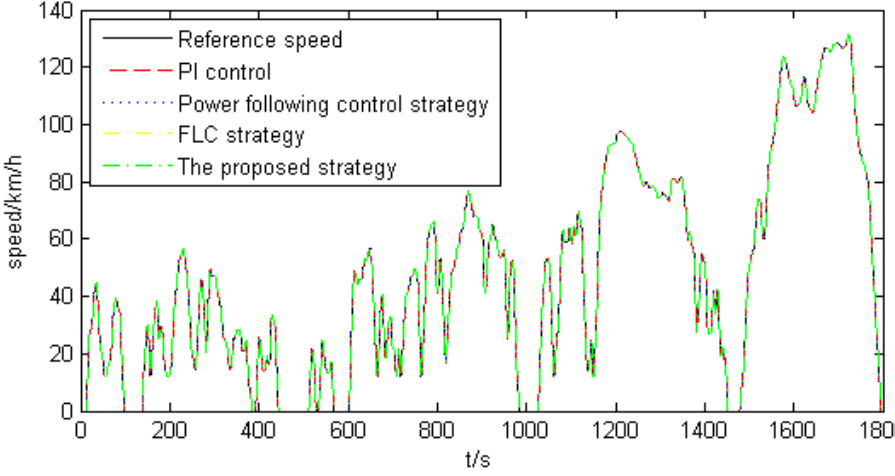
Figure 7. WLTC speed following curve.